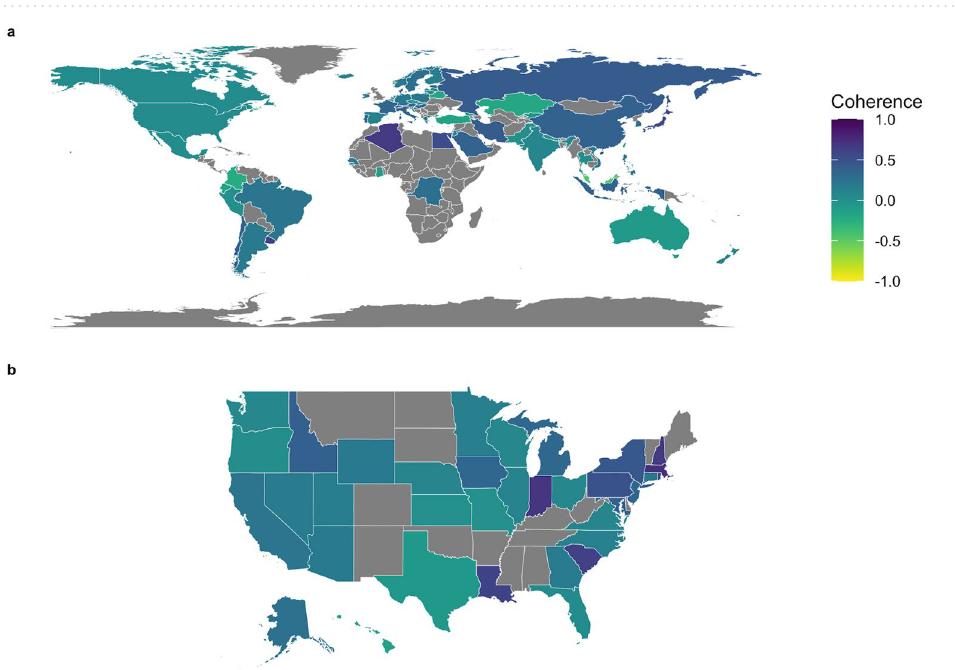
Figure 5. Quantification of coherence of lineages within a specified area compared to other areas. Higher coherence values indicate lower phylogenetic distance within a specific geographic region relative to other areas. ( a ) 15,721 viral genome sequences from infected individuals downloaded from GISAID on May 8th, 2020, and the sequencing data were aligned and used to compare the diversity of SARS-CoV-2 within countries compared to the rest of the world. ( b ) samples from each state of the US have been compared to the rest of the US to investigate the similarity of the virus lineages within each state. Several counties and states exhibited differentiation into specific clades. States or countries with darker colors likely show a higher level of community-driven spread. In contrast, states or countries with lower coherence (lighter colors) show a greater level of disease introduction from outside the region. The figure is implemented in omicsArt 22 , a ggplot2 23 based R 24